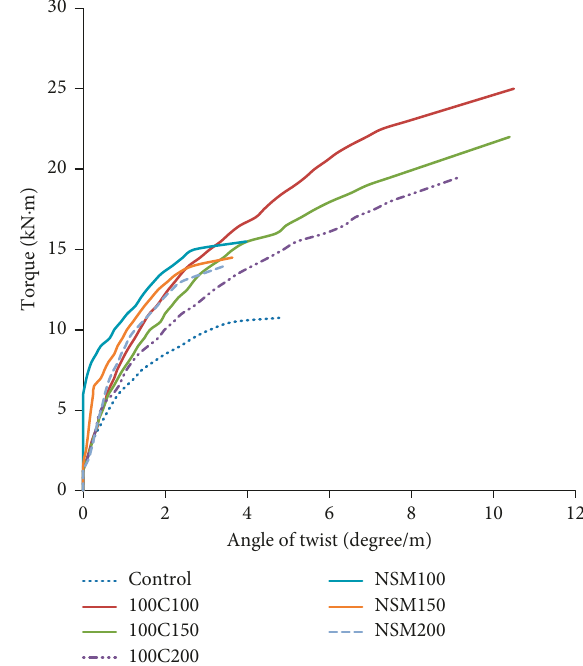
Figure 14: Torque versus angle of twist at each concrete